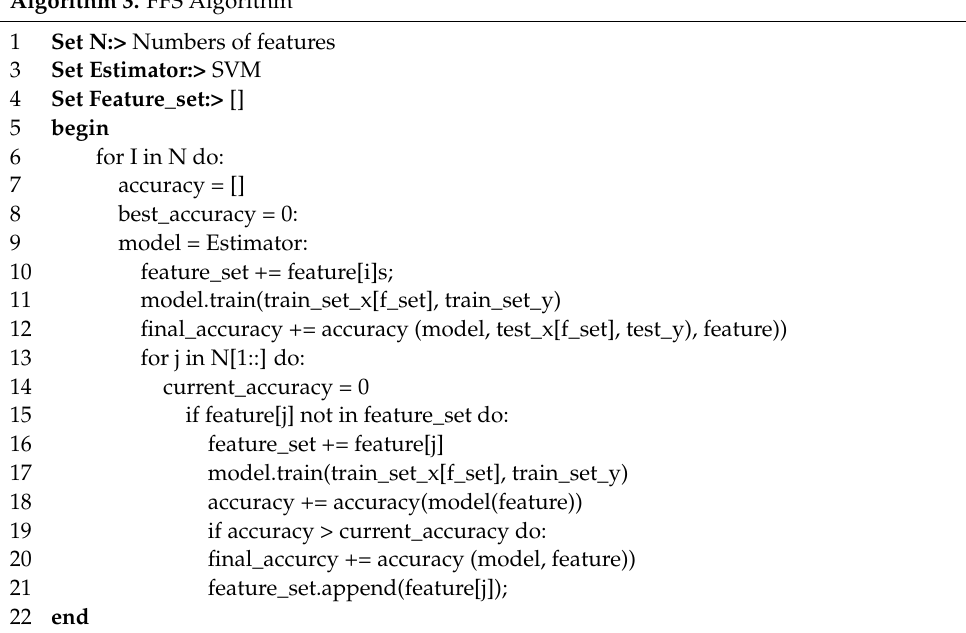
Algorithm 3. FFS